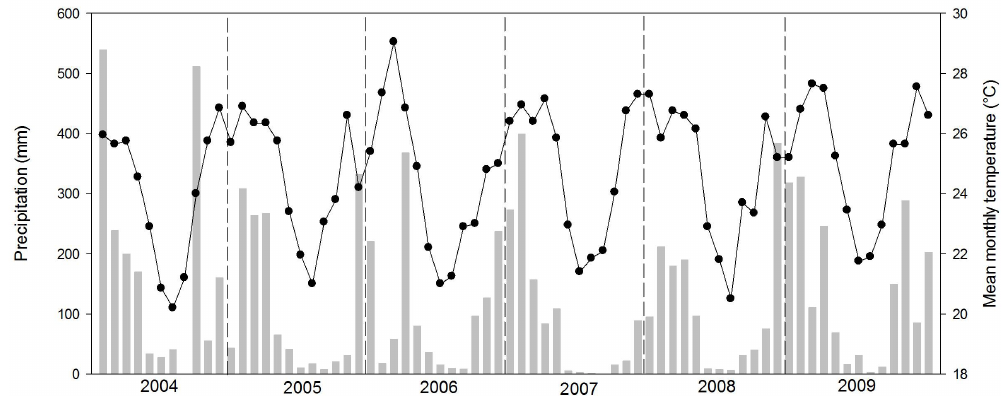
Figure 2. Climate Diagram of the region of Ipatinga between the years of 2004 to 2009. Table 1. Characteristics of the four lakes selected for this study.